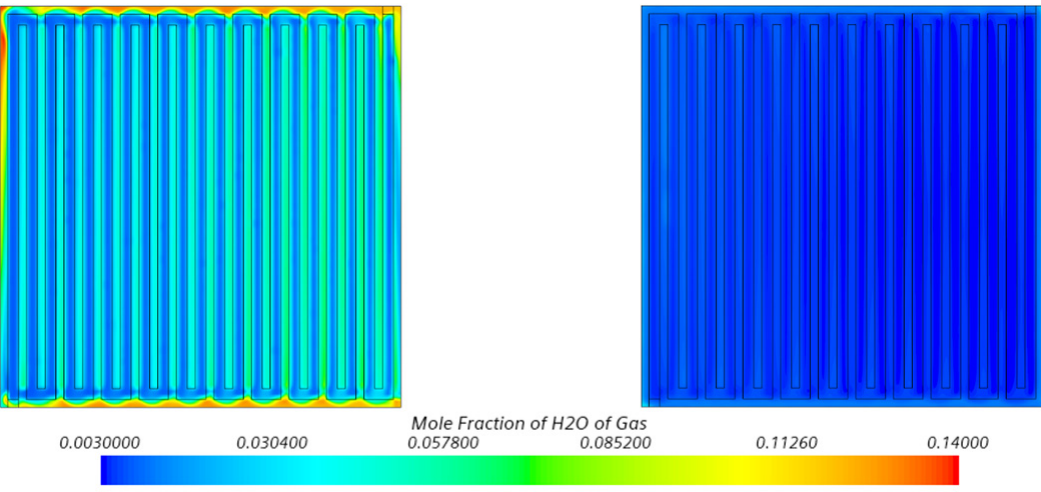
Figure 8. Section views of H 2 O mole fraction at CCL for the 0.2 V ( left ) and the 0.7 V case ( right ).